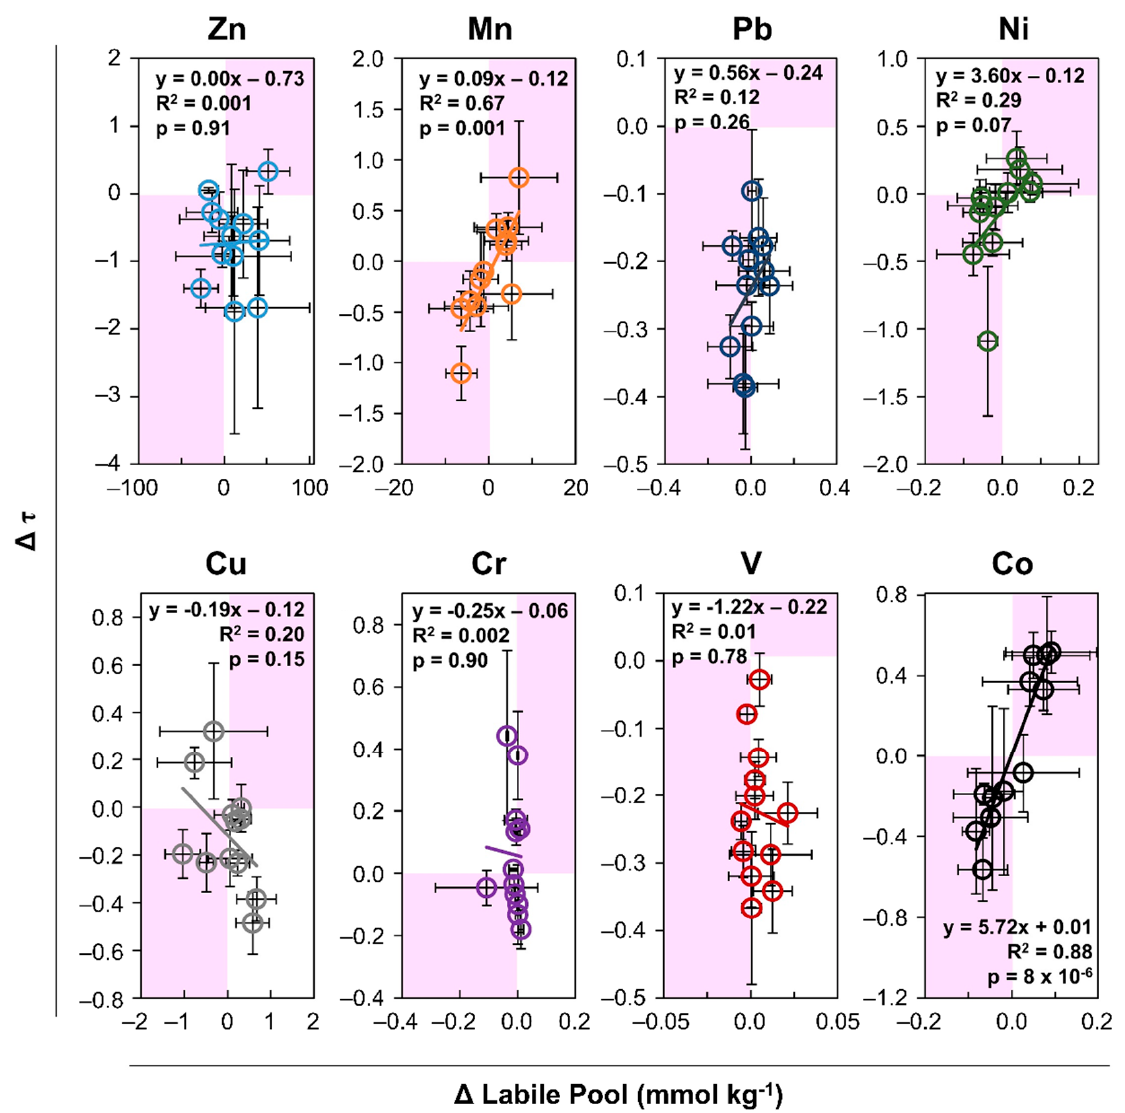
Figure 4. Temporal relationship between labile pool and enrichment/depletion. The relationship between the change over 3 years in the labile pool (sum of water soluble and adsorbed) and change in enrichment/depletion ( ∆ τ ) is shown for depth increments 0–20, 20–40, 40–60, and 60–90 cm for 0% compost control, 10% compost and seed, and 20% compost and seed treatments. Error bars show standard deviation among samples collected from quadruplicate field plots, n = 4 for each depth and treatment. The statistical parameter R 2 indicates goodness of fit of a linear relationship according to the equation shown describing the linear best fit. A statistical parameter p -value < 0.05 describes a statistically significant linear slope reported for a 95% confidence interval ( α = 0.05, n = 12, for a two-tailed test).